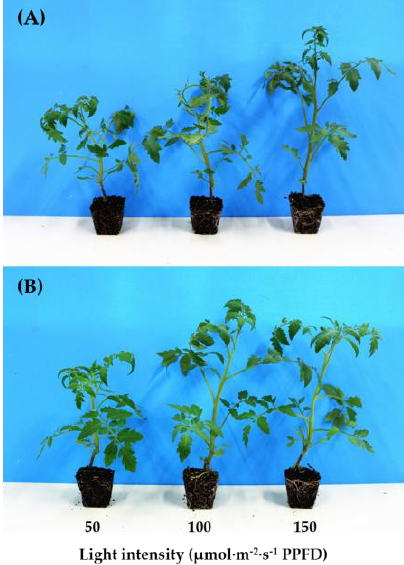
Figure 4. Influence of supplementary light intensity on morphology of ‘SS’ ( A ) and ‘SD’ ( B ) after 10 d of cultivation.